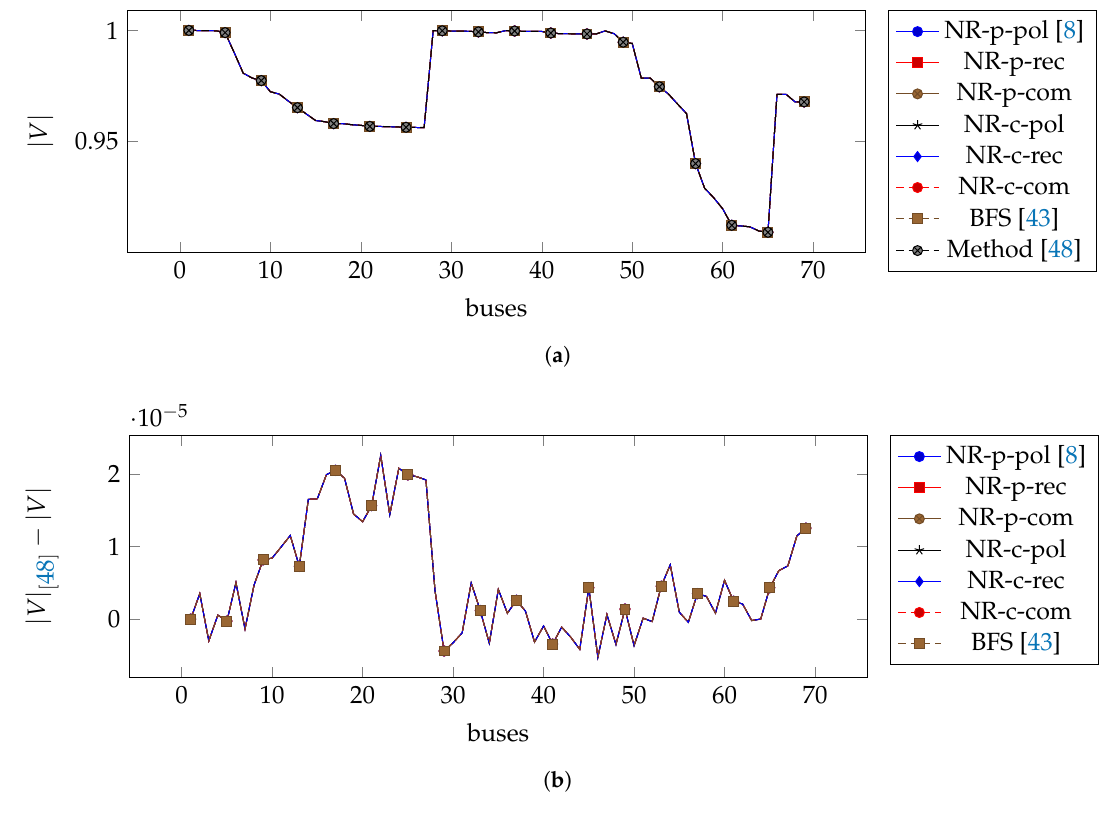
Figure 4. Computed voltage magnitude of DCase69. ( a ) Computed voltage magnitude | V | ; ( b ) Difference between proposed methods and existing method [48] for the computed voltage